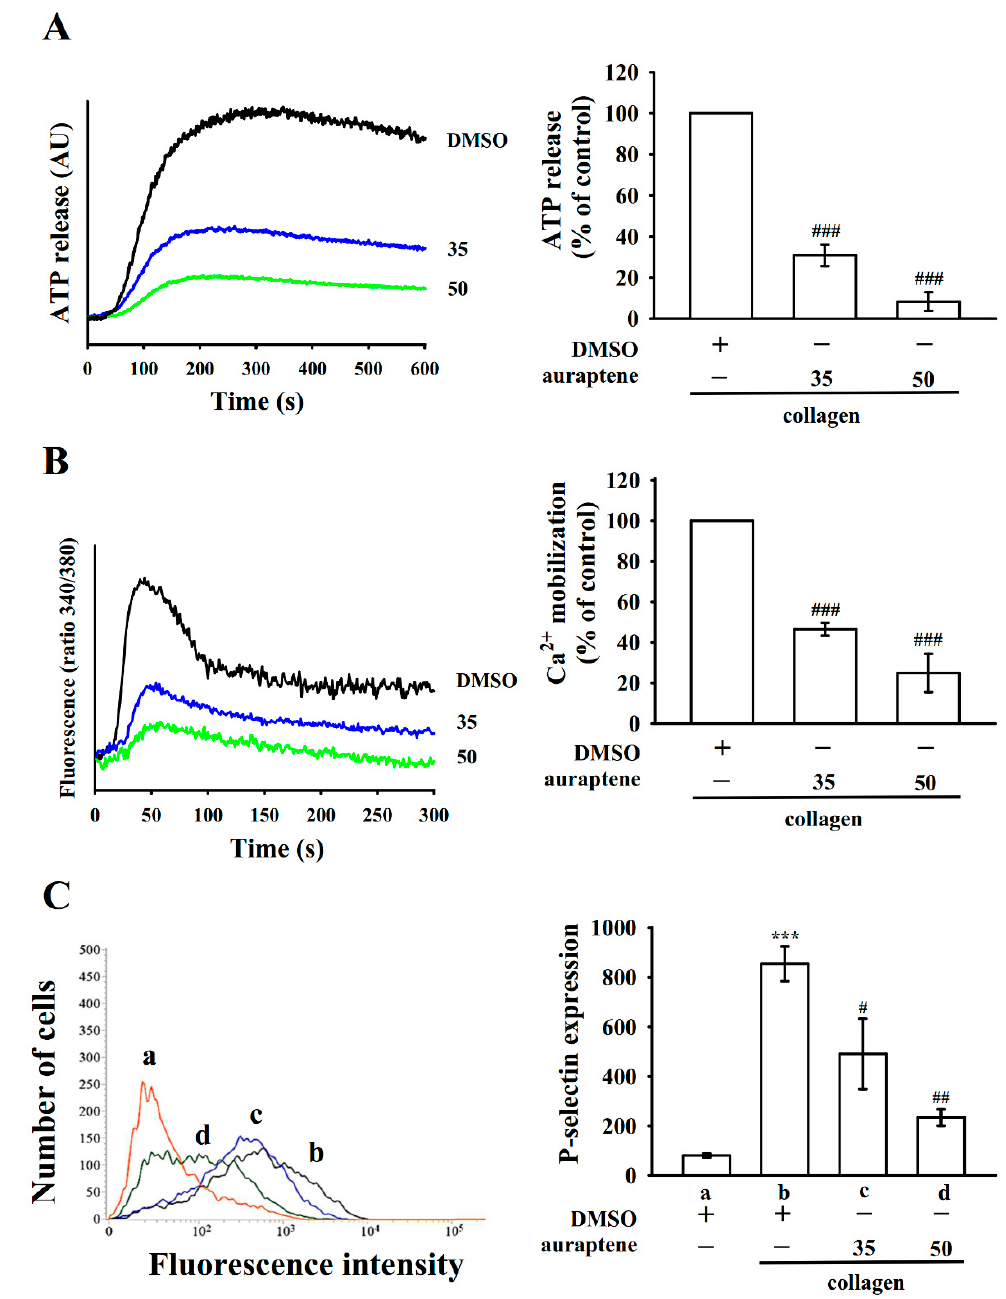
Figure 2. Auraptene reduces collagen-stimulated ATP release, relative [Ca 2 + ]i mobilization, and surface P-selectin expression in human platelets. Washed platelets (3.6 × 10 8 cells / mL) were preincubated with 0.1% DMSO or auraptene (35 and 50 µ M), followed by the addition of collagen (1 µ g / mL) to trigger ( A ) ATP release (AU; arbitrary unit), ( B ) relative [Ca 2 + ]i mobilization, and ( C ) surface P-selectin expression ( a ) Resting platelets (DMSO-treated) or platelets were preincubated with 0.1% DMSO ( b ) or auraptene ( c , 35; d , 50 µ M), as defined in the materials and methods. The corresponding statistical data are displayed on the right panel of each figure. Data are presented as mean ± SEM ( n = 4). *** p < 0.001 compared with the resting control; # p < 0.05, ## p < 0.01, and ### p < 0.001, compared with the 0.1% DMSO-treated group.